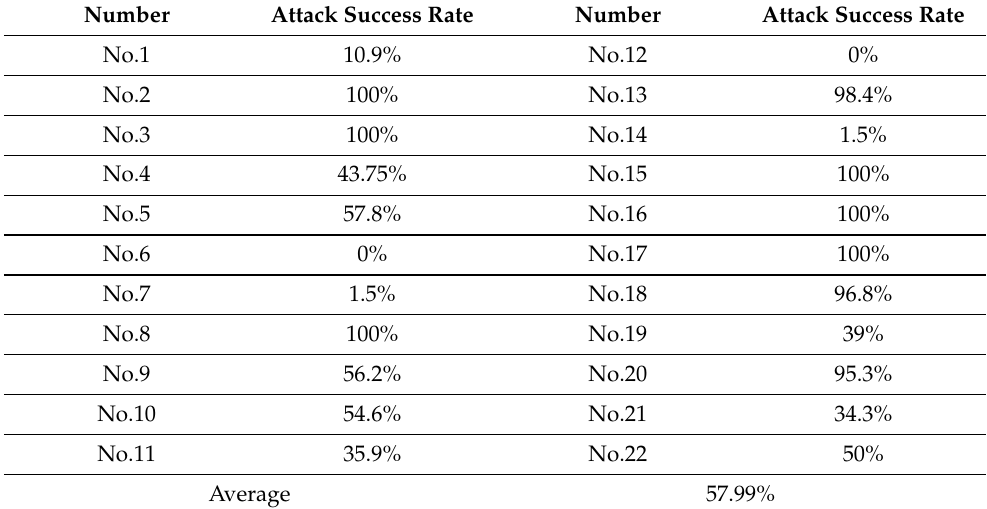
Table 7. Digital Dodging Attack in 22 people’s